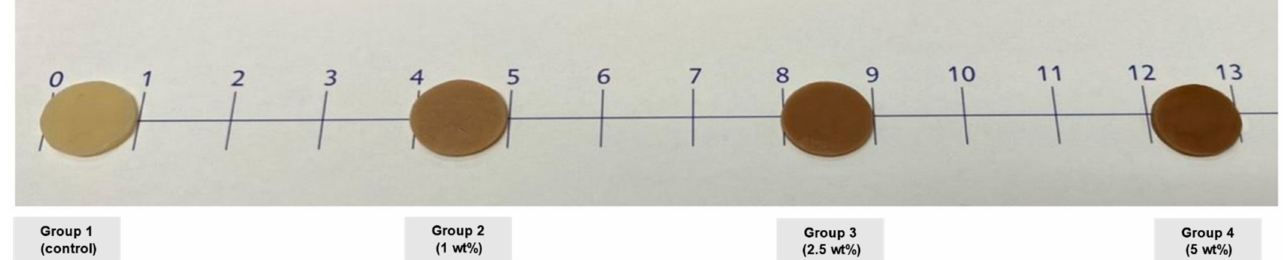
Figure 4. Appearance of specimens after mixing with color modifier.